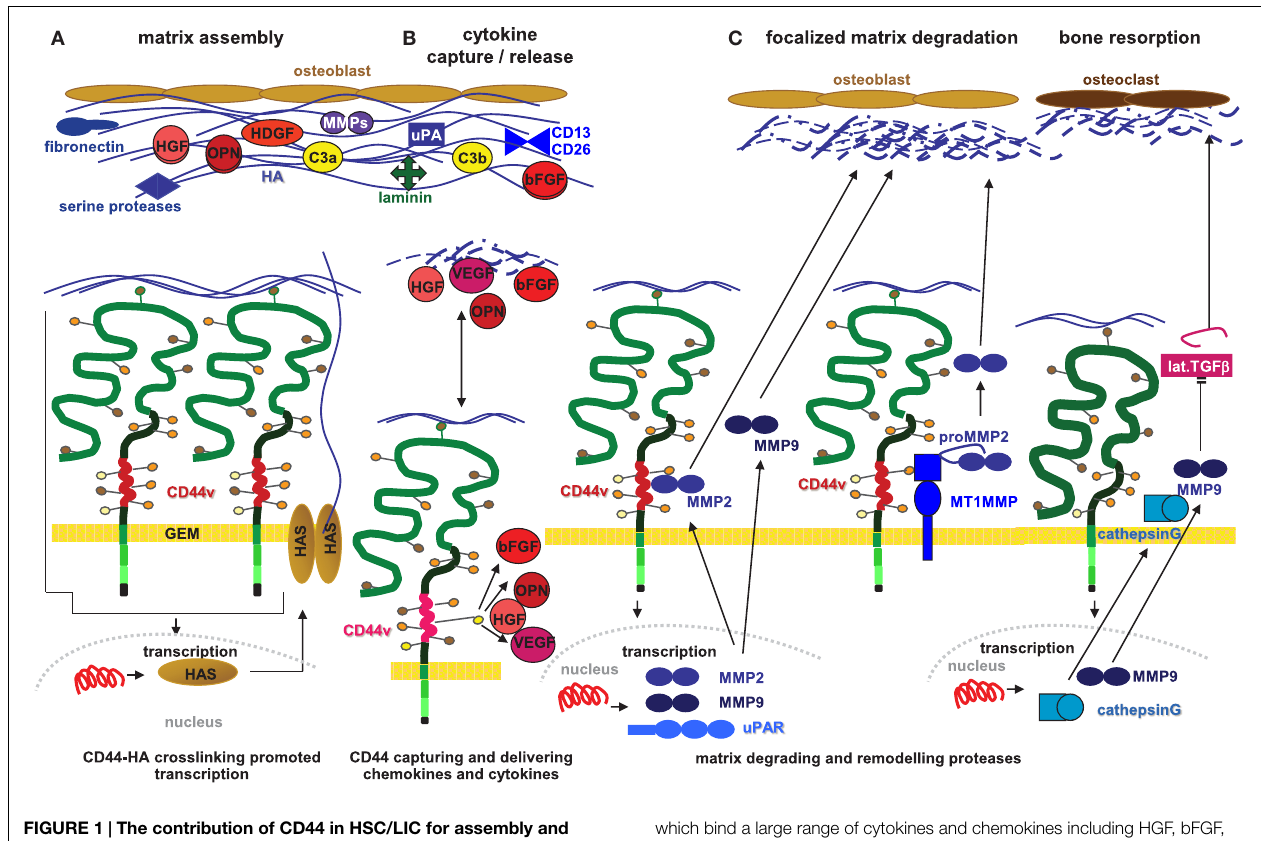
FIGURE 1 | The contribution of CD44 in HSC/LIC for assembly and modulation of the osteogenic niche . (A) HSC secrete large amounts of HA. Upon HA crosslinking, CD44 becomes activated, which supports transcription of HAS3, which strengthens the process of high MW HA deposition and incorporation of cytokines, chemokines, and proteases in the abundant HA coat. (B) HSC quiescence and LIC proliferation are supported by the catcher activity of CD44/CD44v6 and most pronounced CD44v3 associated GAG,